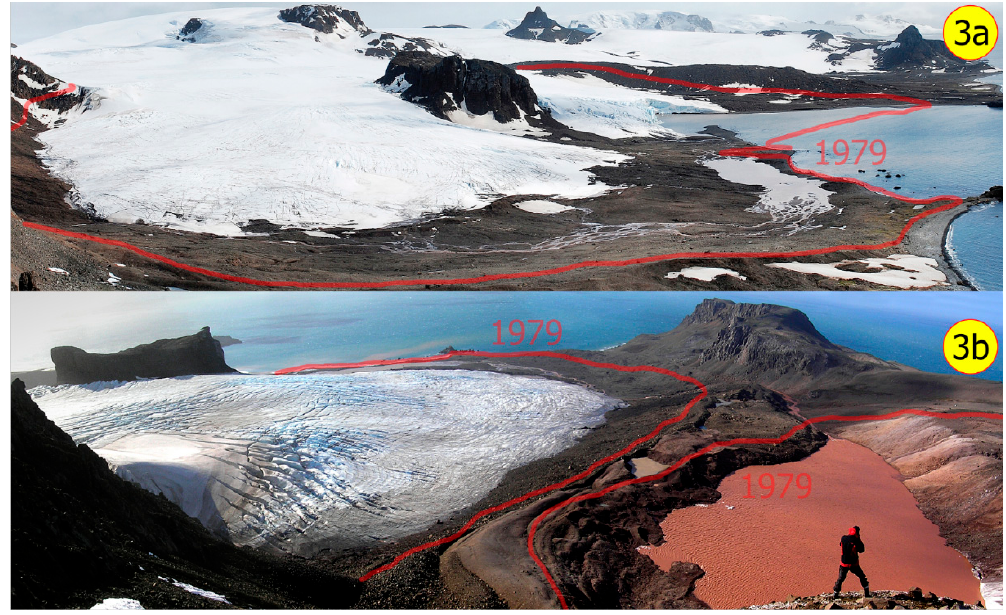
Figure A3. Forefield of the Baranowski Glacier (3a), the southern side moraine (3b). Photo bases marked on Figure 5.